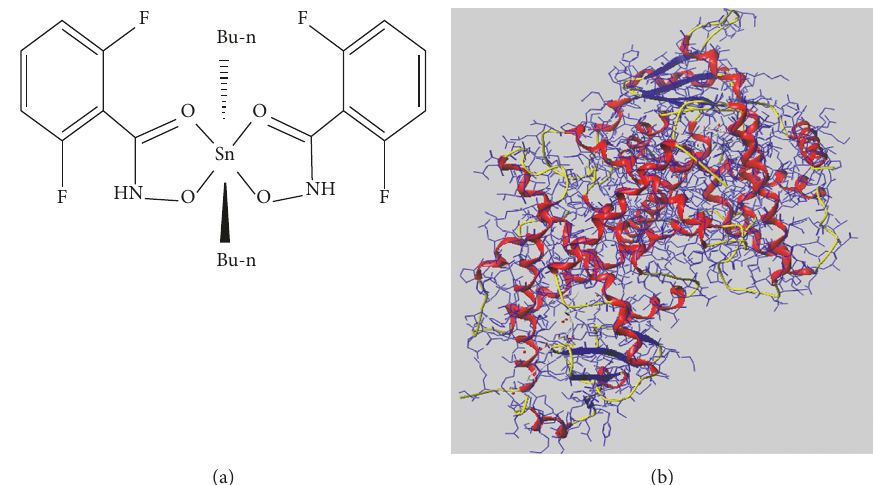
Figure 1: Structures of DBDF2,6T and hPPAR c protein: (a) 2D structure of DBDF2,6T and (b) 3D structure of PPAR c